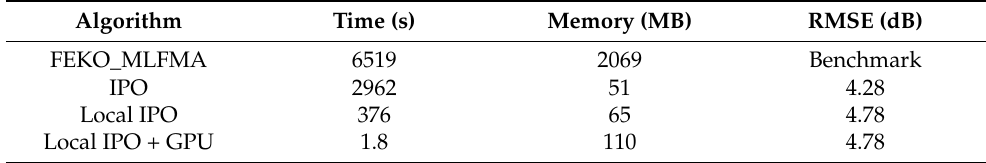
Table 1. The calculation time and accuracy of each algorithm.